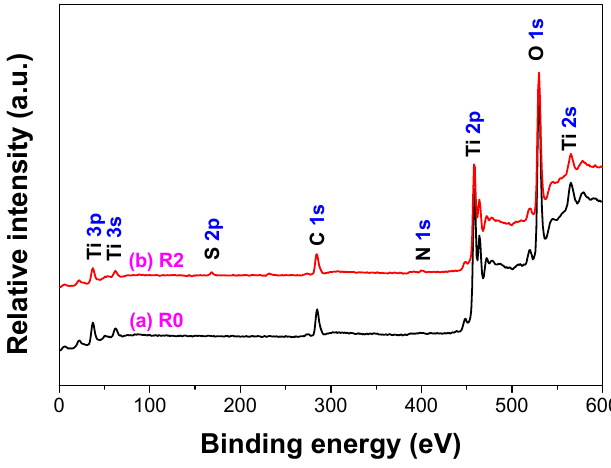
Figure 5. XPS survey spectra of pristine R0 ( a ) and thiourea-modified TiO 2 nanorods of R2 ( b ).